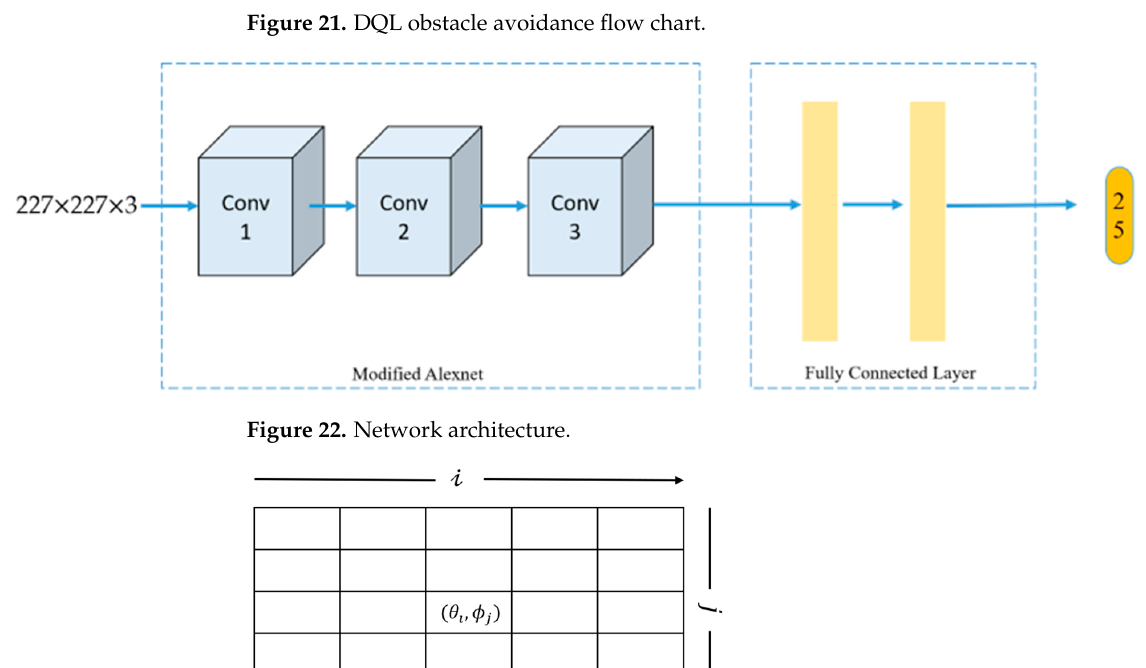
Figure 22. Network architecture.